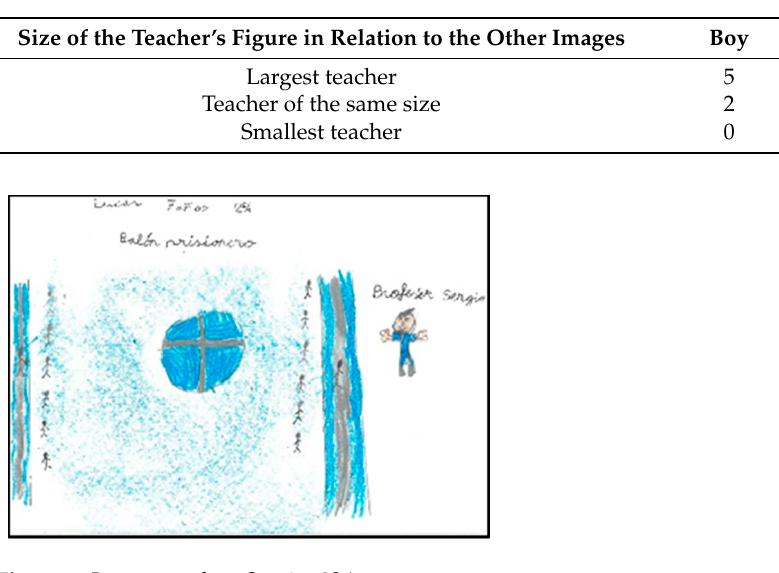
Figure 1. Children playing Pichi. Alejandro. 1°B. Table 1. Representation of the teacher.